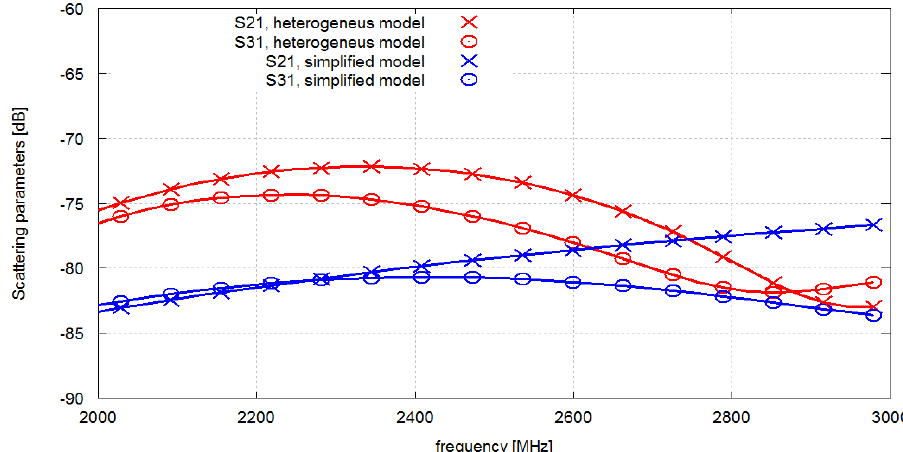
Figure 11. Comparison of results obtained with simplified model and heterogeneous model.